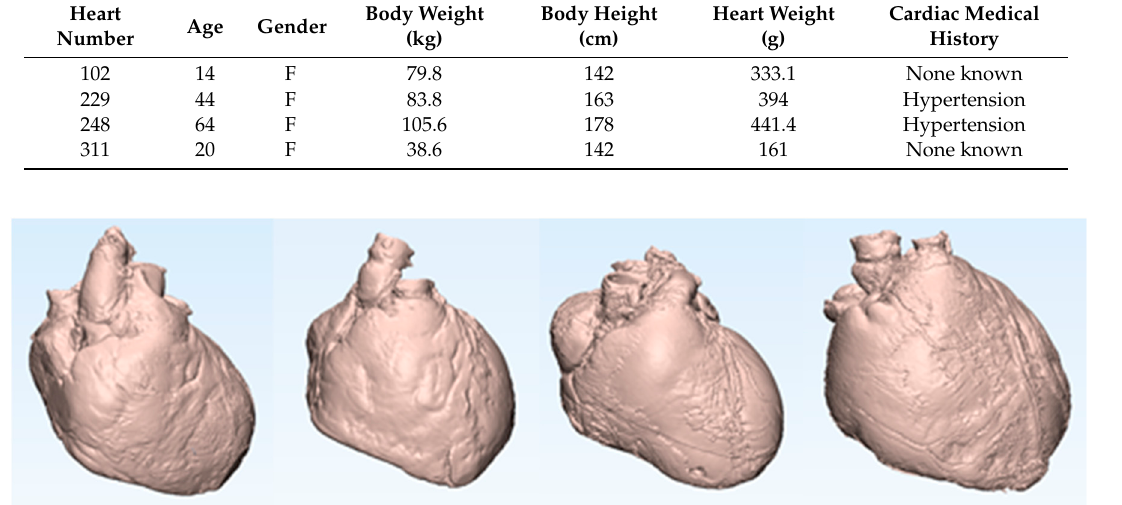
Figure 3. Computational 3D models of four MRI scanned human hearts from the Visible Heart ® Laboratories (left to right: HH229, HH248, HH102, and HH311). These models were used for subsequent computational implants of cardiac devices.